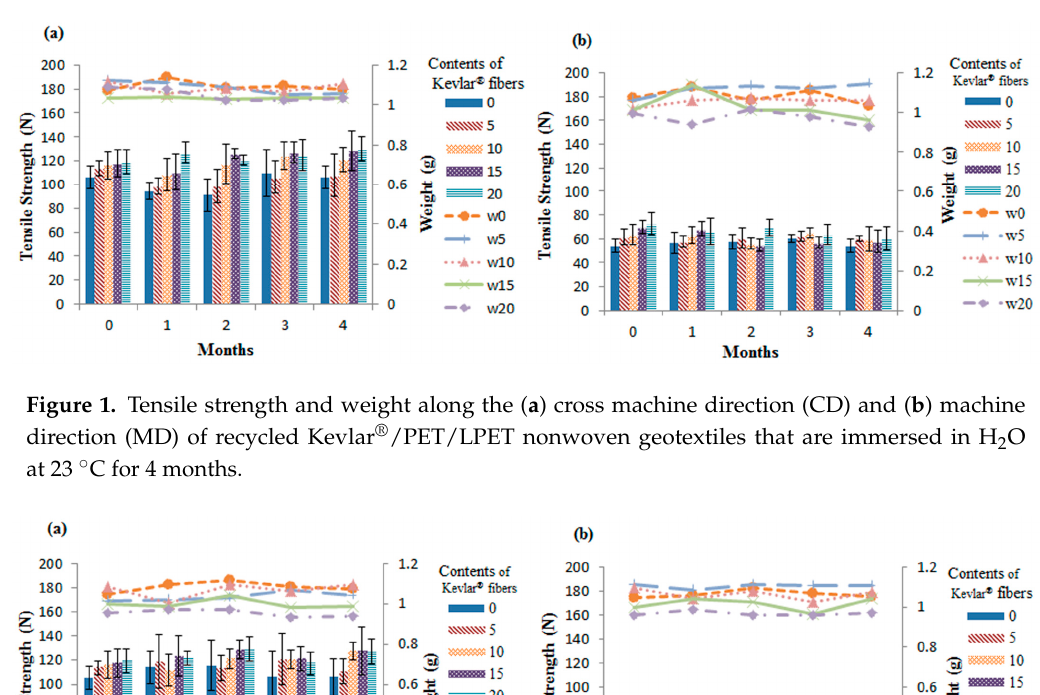
Figure 3. Tensile strength and weight along the (a) CD and (b) MD of recycled Kevlar ® /PET/LPET nonwoven geotextiles that are immersed in CH 3 COOH at 23 °C for 4 months.